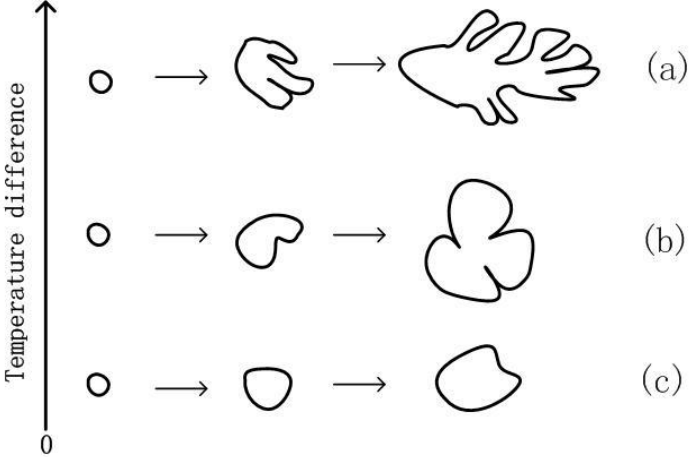
Figure 13. Schematic illustration of grain growth with temperature difference around the